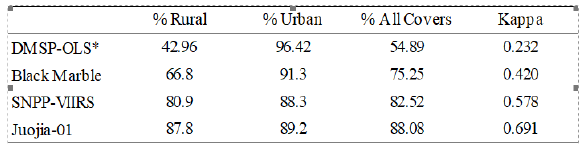
Table 6. Adjustment accuracy indicators (MRB)